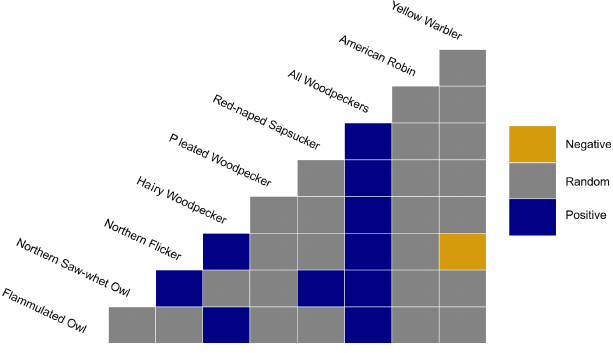
Fig. 2 . Species co-occurrence matrix for all possible pairwise comparisons between cavity nesting forest owls and woodpeckers in the Boise National Forest, Idaho, USA. Species co-occurrence was also investigated between owls and two passerines and was random. Yellow Warbler ( Setophaga petechia ); American Robin ( Turdus migratorius ); Red-naped Sapsucker ( Sphyrapicus nuchalis ); Pileated Woodpecker ( Dryocopus pileatus ); Hairy Woodpecker ( Picoides villosus ); Northern Flicker ( Colaptes auratus ); Northern Saw-whet Owl ( Aegolius acadicus ); Flammulated Owl ( Psiloscops flammeolus ).